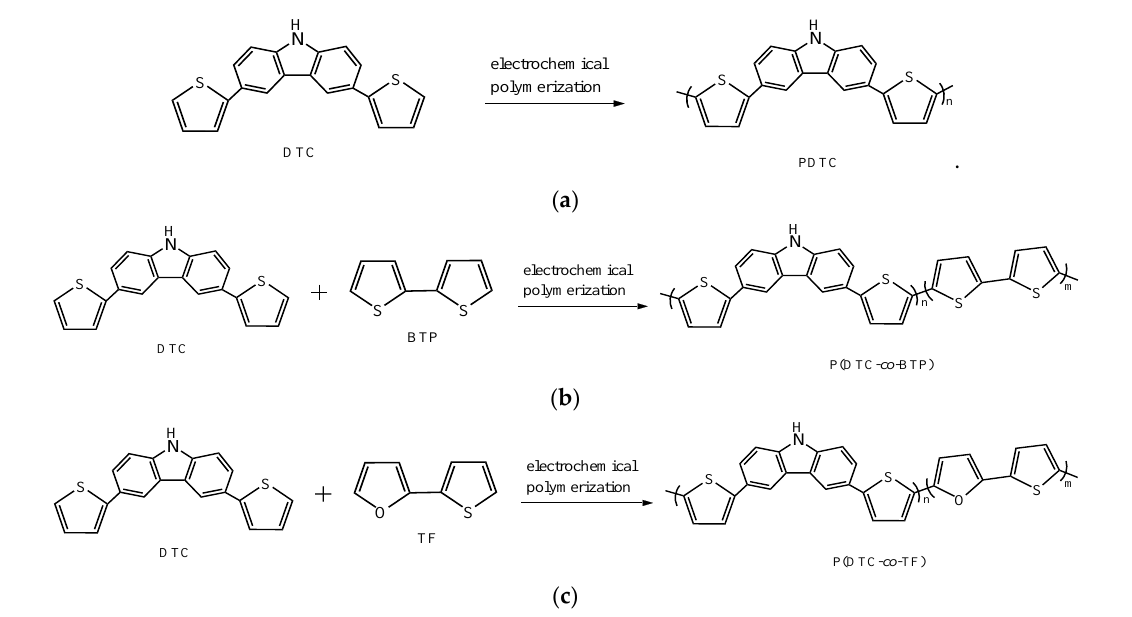
Figure 3. The electrochemical polymerization schemes of ( a ) PDTC, ( b ) P(DTC- co -BTP), and ( c ) P(DTC- co -TF). Figure 4 shows the CV curves of PDTC, P(DTC- co -BTP), P(DTC- co -BTP2), P(DTC- co -TF), and P(DTC- co -TF2) films at scan rates of 10, 50, 100, 150, and 200 mV s − 1 in 0.2 M LiClO 4 /ACN . The anodic and cathodic peaks of PDTC, P(DTC- co -BTP), P(DTC- co -BTP2), P(DTC- co -TF), and P(DTC- co -TF2) membranes displayed quasi-reversible behaviors and the inset in Figure 4 revealed that the redox peak current density increased with the increasing scan rate linearly, demonstrating that the oxidation and reduction processes of PDTC, P(DTC- co -BTP), P(DTC- co -BTP2), P(DTC- co -TF), and P(DTC- co -TF2) films were not diffusion-limited [34].